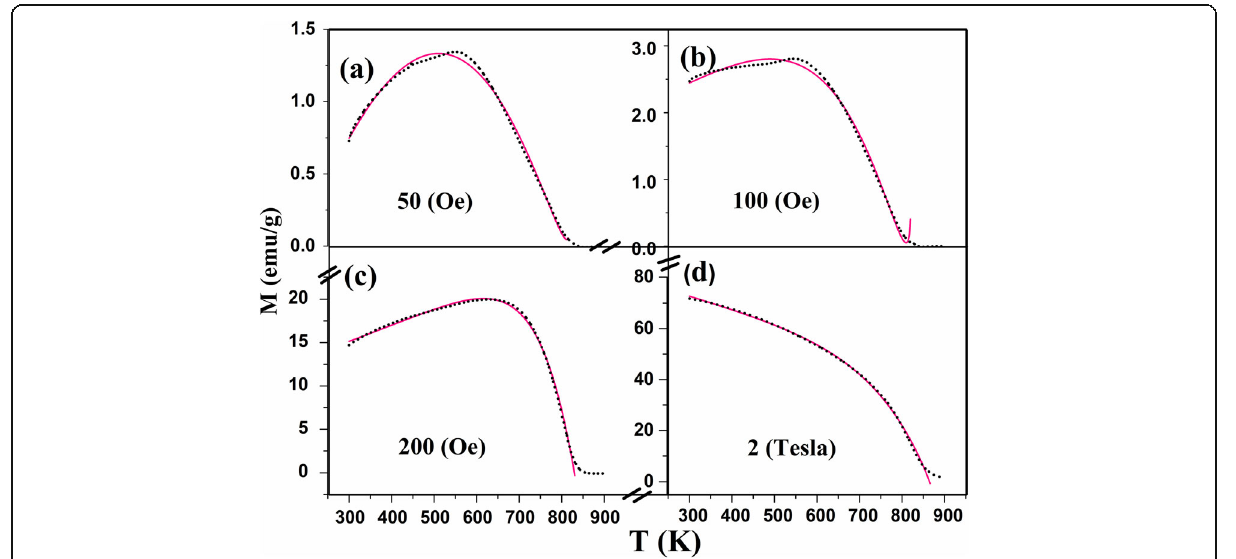
Fig. 12 Change of magnetization ( M ) with temperature during heating (after 3rd cycle) of the heated pristine Fe 3 O 4 nanoparticles while applying different magnetic field H of a 50 (Oe), b 100 (Oe), c 200 (Oe), and d 2 T (black dotted, experimental; pink solid, fitted using Eq.